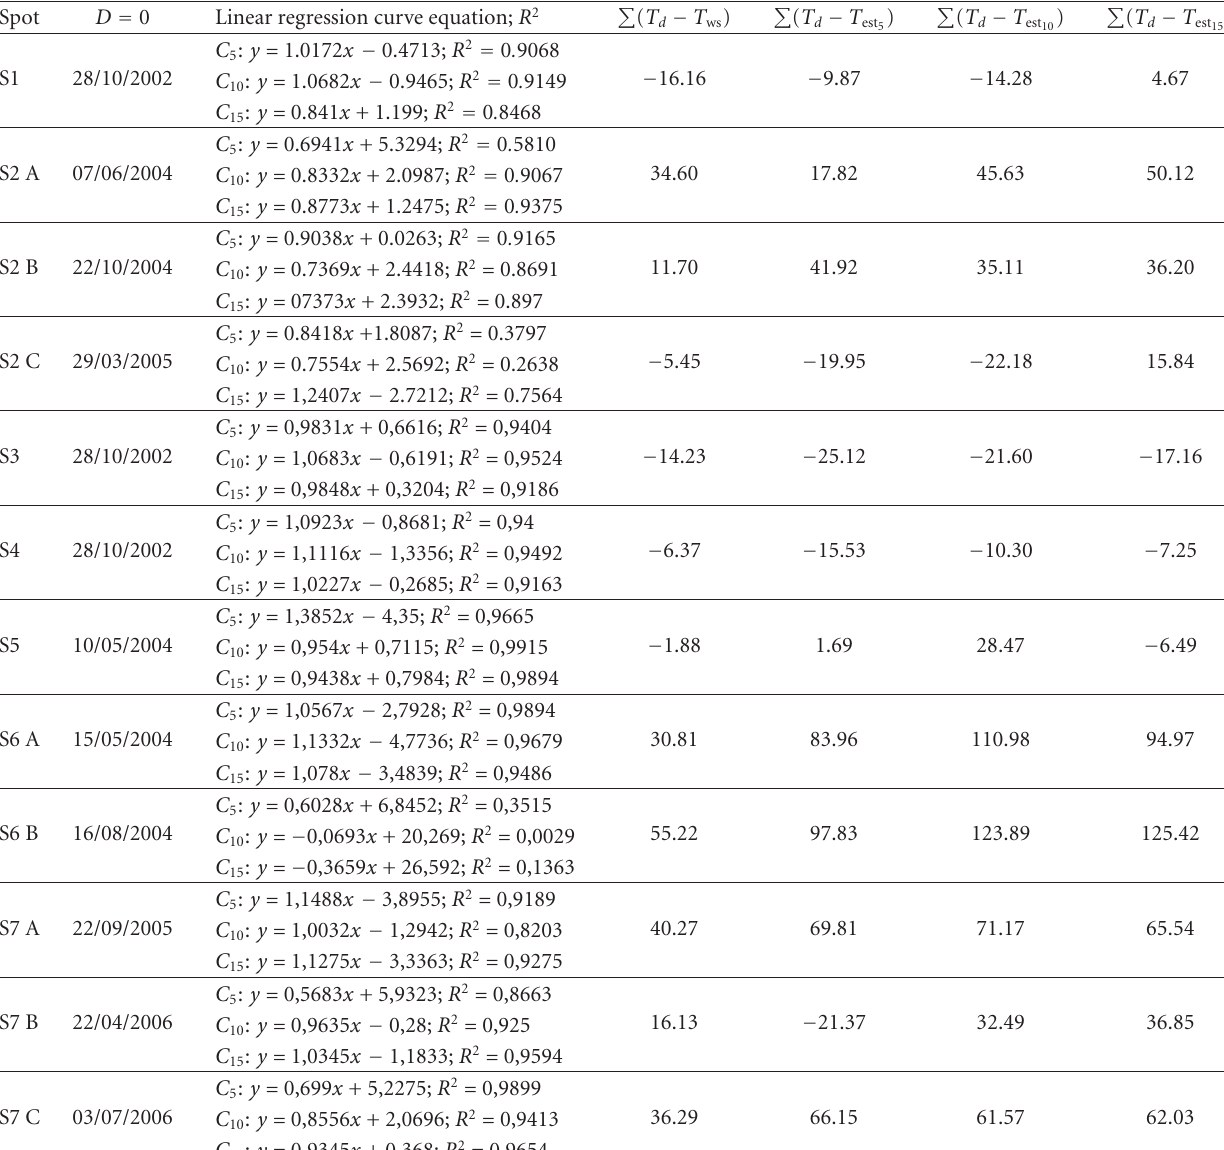
Table 3: Summation of the di ff erence between T d and others temperatures ( ◦ C) data for 25 days. Spot D = 0 Linear regression curve equation; R